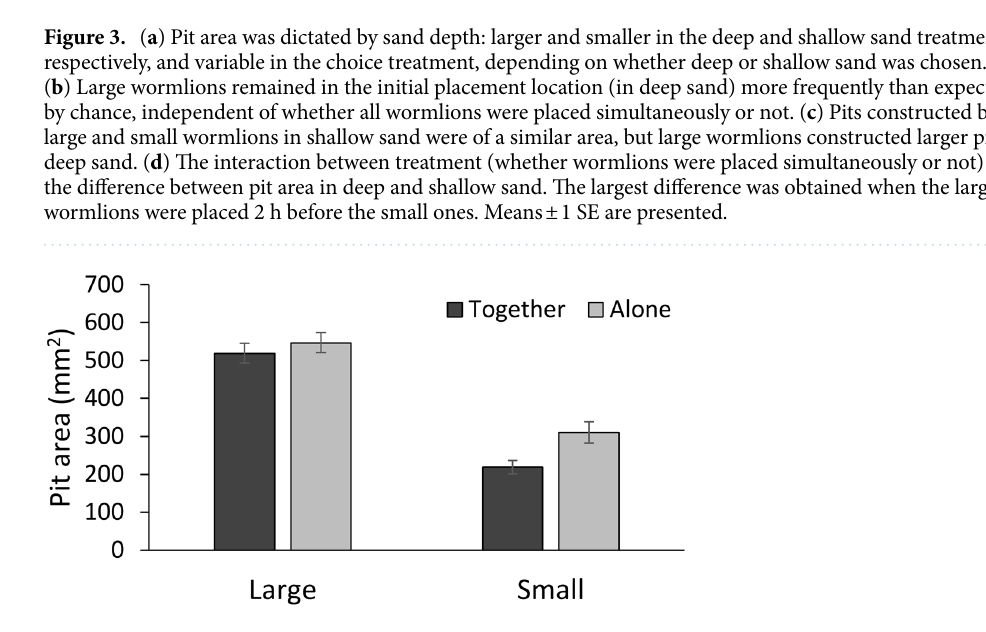
Figure 4. The area of constructed pits was smaller when wormlions were placed together under limited space than when placed alone. This decrease in the area was uniform among both large and small individuals. Means ± 1 SE are